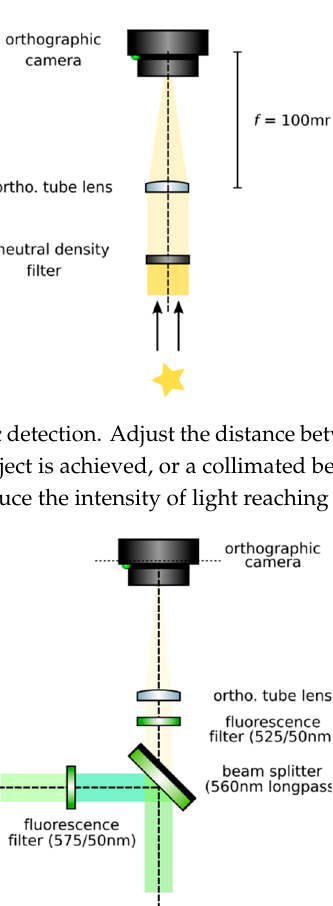
Figure 9. Insert a beam splitter and two fluorescence filters before the tube lens.